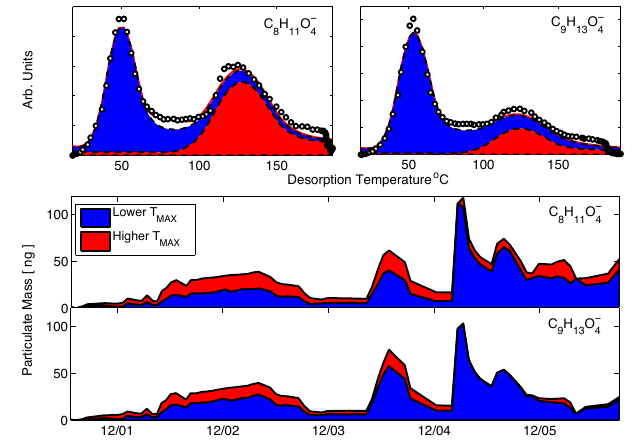
Figure 3. Top panels: thermograms for two ion compositions, each showing two distinct modes in the thermogram, are plotted show- ing the results of fitting desorption profiles characteristic of an in- dividual compound with a specific enthalpy of sublimation. The first, lower temperature, modes are consistent with the correspond- ing carboxylic acid desorbing as a non-interacting component of the collected organic aerosol. We attribute the second, higher tem- perature modes, to thermal decomposition of lower volatility com- pounds (such as oligomers or highly functionalized monomers) which are thermally unstable and which presumably do not affect the partitioning of the primary acids between the gas and particle phases. Lower Panels: the time series of the individual peak inte- grations within a fitted thermogram for the two different ion com- positions across all chamber conditions. A significant fraction of the total detected signal arises from thermal decomposition (red) during desorption. Evident is the nearly complete disappearance of the second mode in C 9 H 13 O − (pinic acid) during OH oxidation, 4 suggesting that it is derived from a precursor that is only present during ozonolysis or which is reacted away in the presence of